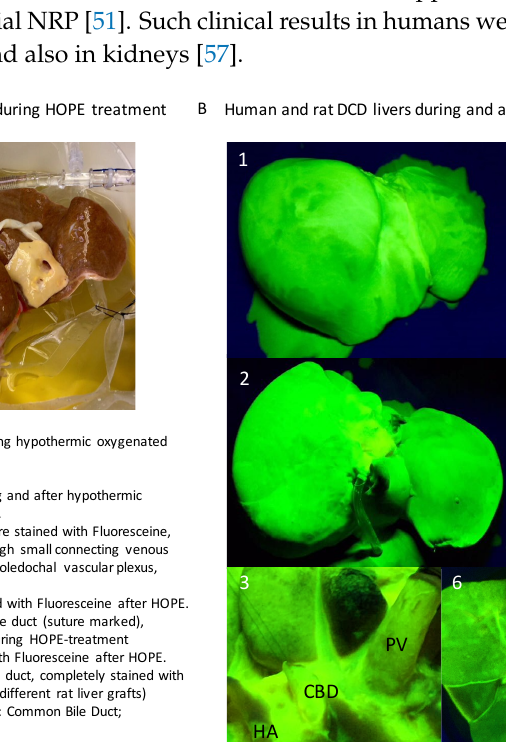
Figure 3. Hypothermic oxygenated perfusion (HOPE) in human and rat DCD livers. ( A ) An